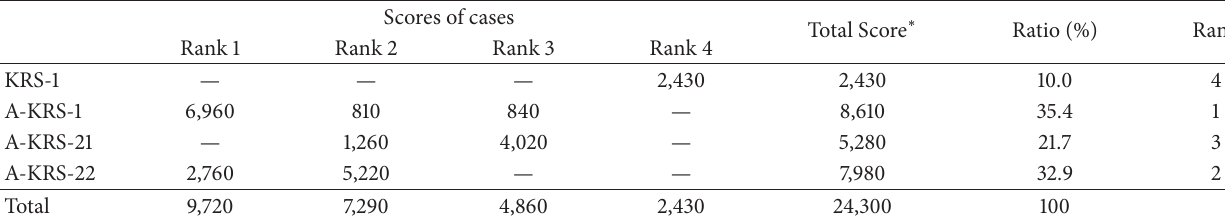
Table 8: The results of efficiency rank scores for all cases. Scores of